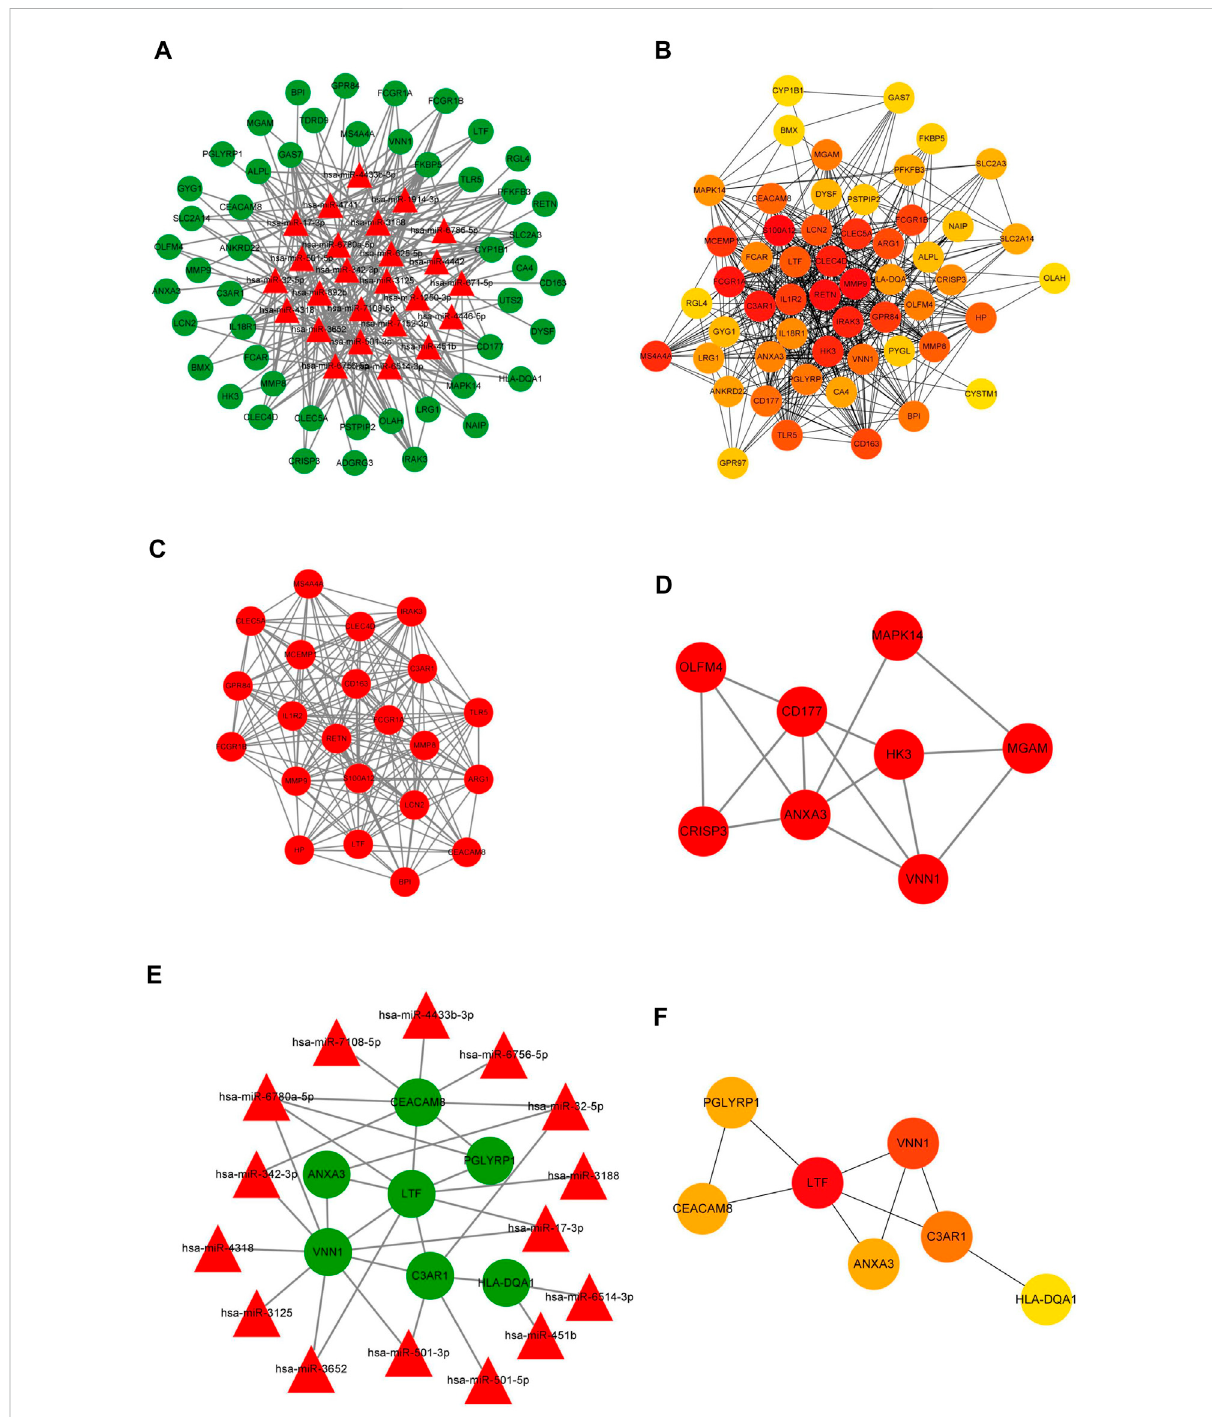
Constructionofthemembrane-relatedinteraction network. (A) ThecompetitiveendogenousRNA(ceRNA)networkofDEGsintheinitiationof sepsis. In total, there were 25 miRNAs and 50 mRNAs in the ceRNA network. (B) The target genes of the identi fi ed DEmRNAs were ranked in the PPI network.Thedepthofredindicatestheimportanceofgenesinthenetwork. (C) Themostclosely-clusteredsubnetworkwascomposedof22nodes and 178 edges. (D) The clustered subnetwork identi fi ed by the MCODE plug-in in Cytoscape had 8 nodes and 15 edges. (E) The membrane- related interaction network in the initiation of sepsis. Based on the results of the prediction of DEmiRNAs and PPI network, we constructed a autophagy interaction network including 15 miRNAs and seven mRNAs. (F) In the membrane-related interaction network, LTF, VNN1, and C3AR1 were the most important hub gene among the identi fi ed genes. The depth of red indicates the importance of genes in the network among